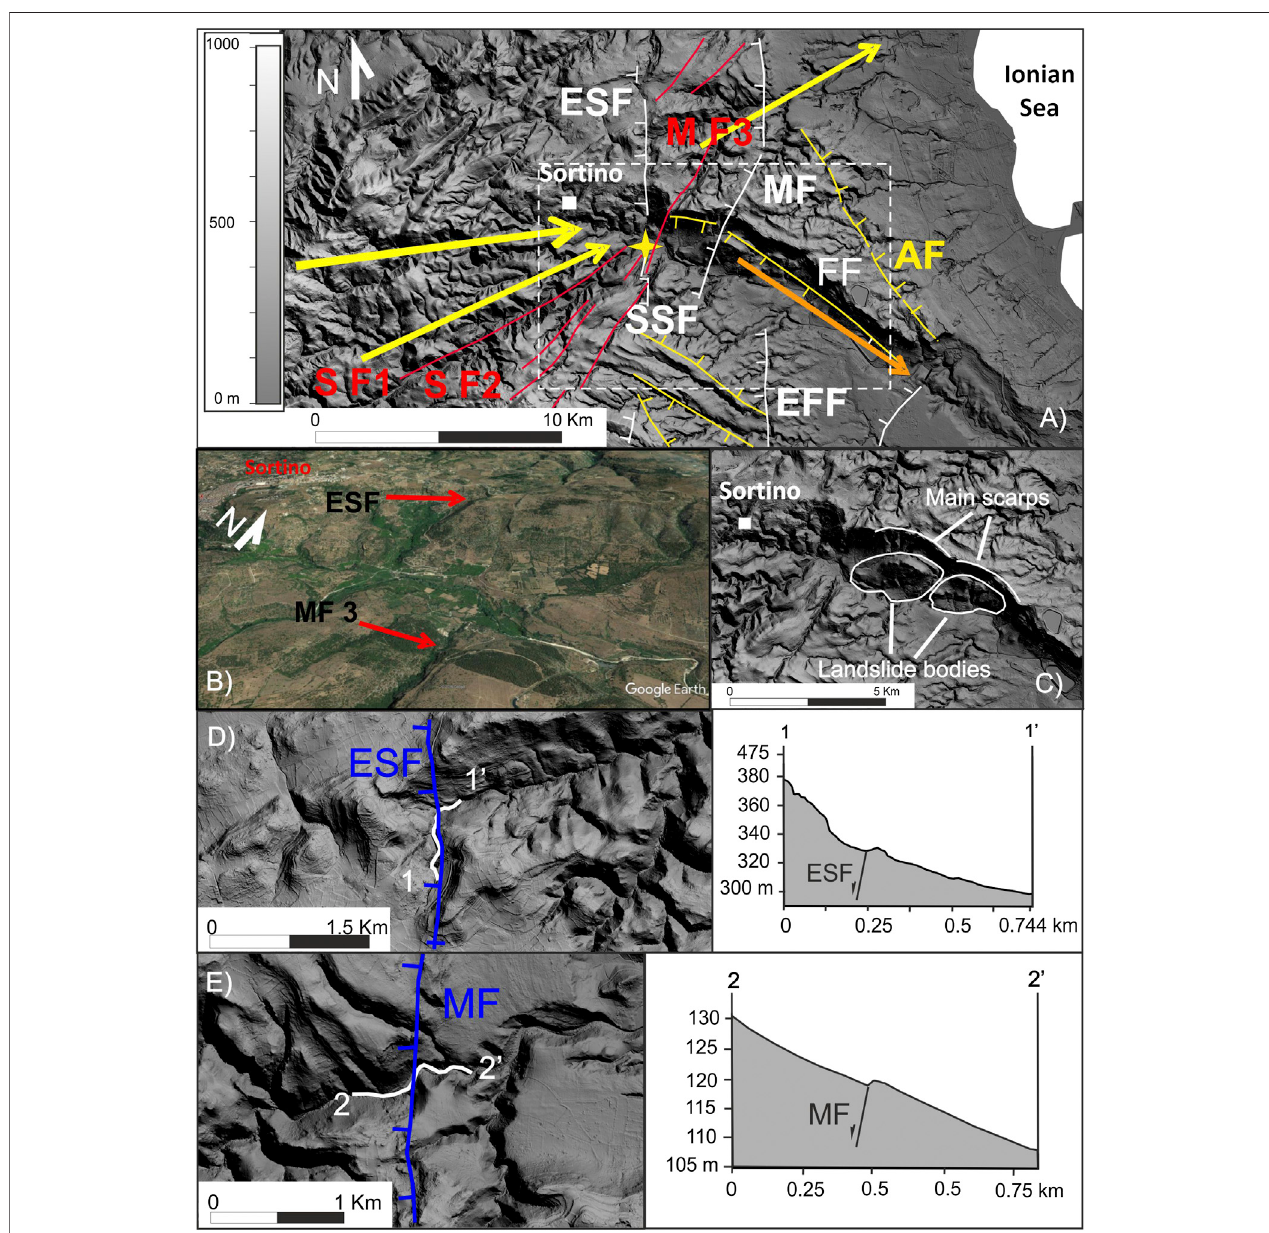
FIGURE 12 | (A) DEM detail of the central part of the Anapo River ( fi gure location in Figure 6B ) showing the direction change of the drainage network due to ESF and FF activity, which caused the uplift of a block north of the Anapo River partially coincident with the Augusta Horst. Yellow arrows on the left indicate the present-day ENE – WSW direction of the western sector of the Anapo River; in the eastern sector, orange and yellow arrows indicate the present-day NW-SE direction and the old direction of the Anapo River, respectively. The latter corresponds to the actual Cantera River. White lines are the river watersheds. Yellow star is the location of the google earth image of Figure 8B . (B) Google Earth image showing ESF and MF3. (C) Detail of the DEM showing two paleo-landslides along FF to the east of Sortino, likelytriggeredbythe1693earthquakes.LandslidebodiesareerodedandincisedbytheAnapoRiver. (D) DEMandmainchannelpro fi lesoftheCanteraRiver,whereitis intercepted by ESF and (E) by MF; (see Figure 11D